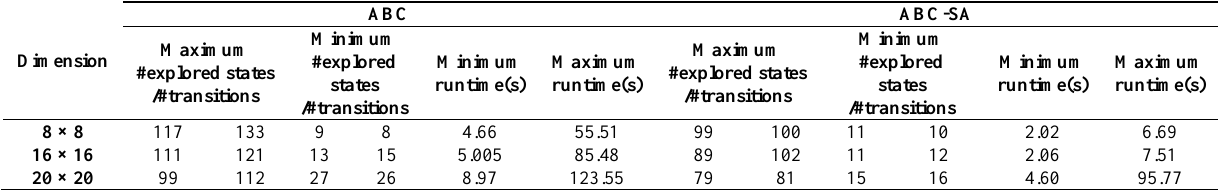
Table 7. Running details of the ABC and ABC-SA approaches in the N-Queen problem.